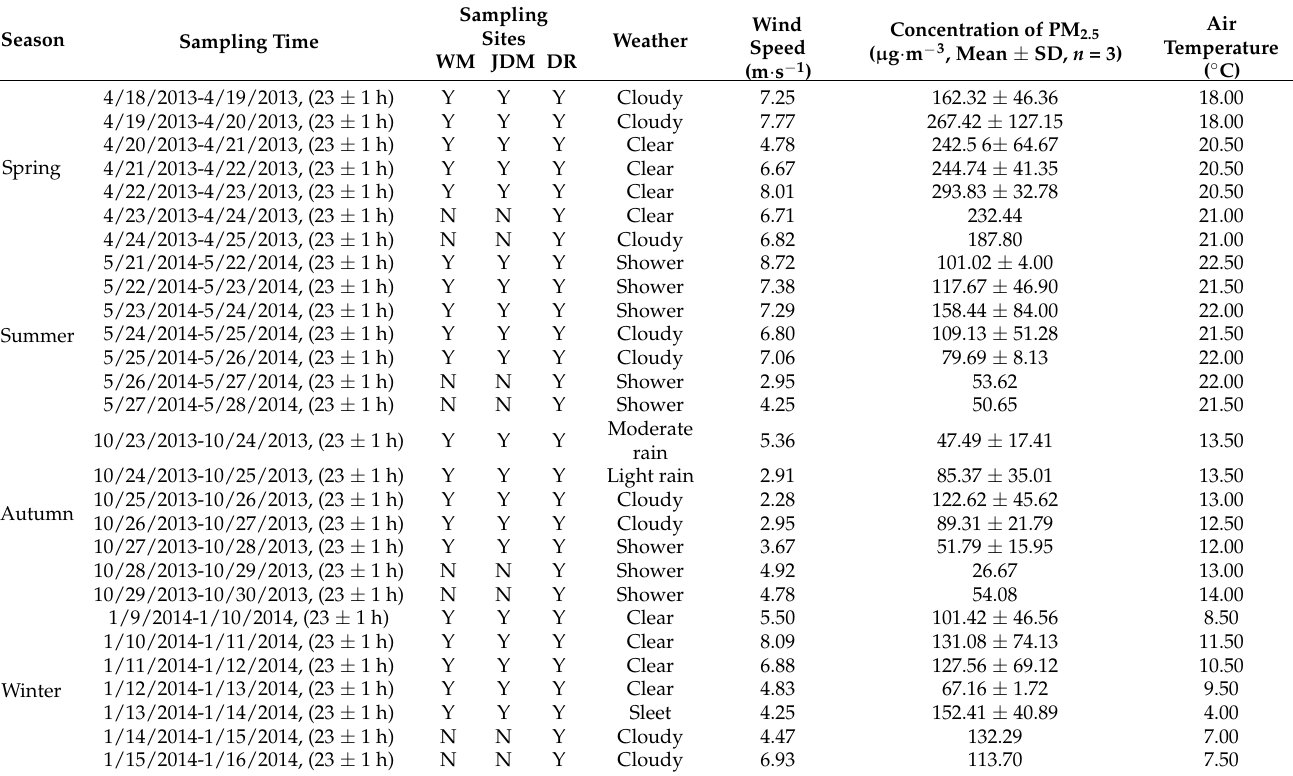
Figure 1. Location map of the sampling sites in Kunming (WM: West Mountain, Clean reference sampling site; JDM: Jinding Mountain, Industrial sampling site; DR: Dongfeng East Road, Traffic- intensive sampling site; km: kilometer; N in the upper left corner of the picture: North arrow; N on the ordinate in the figure: North latitude; E on the abscissa in the figure: East longitude). Table 1. Sampling time and weather conditions at three sampling sites in